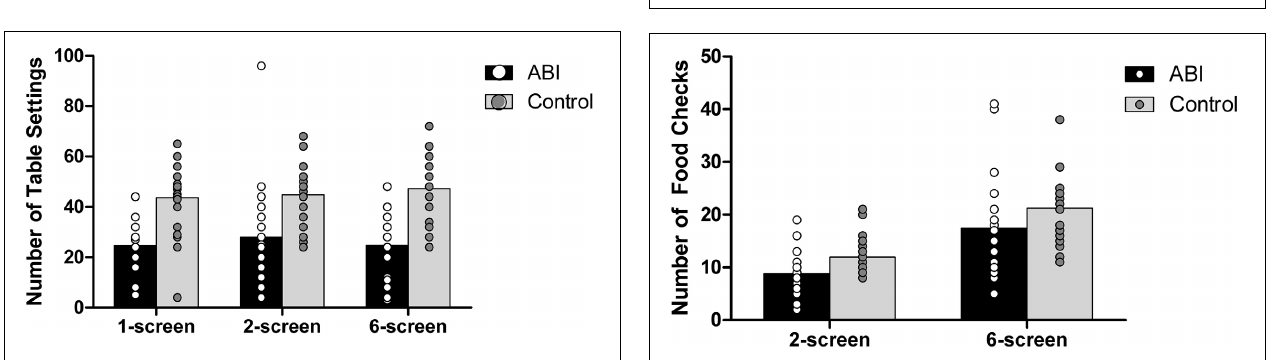
FIGURE 11 | Number of food